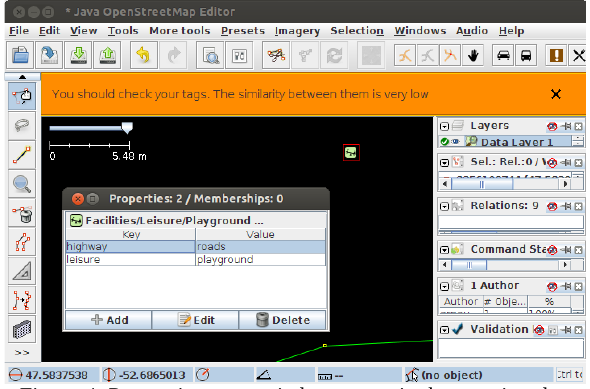
Figure 4. Preventing semantic heterogeneity by warning the